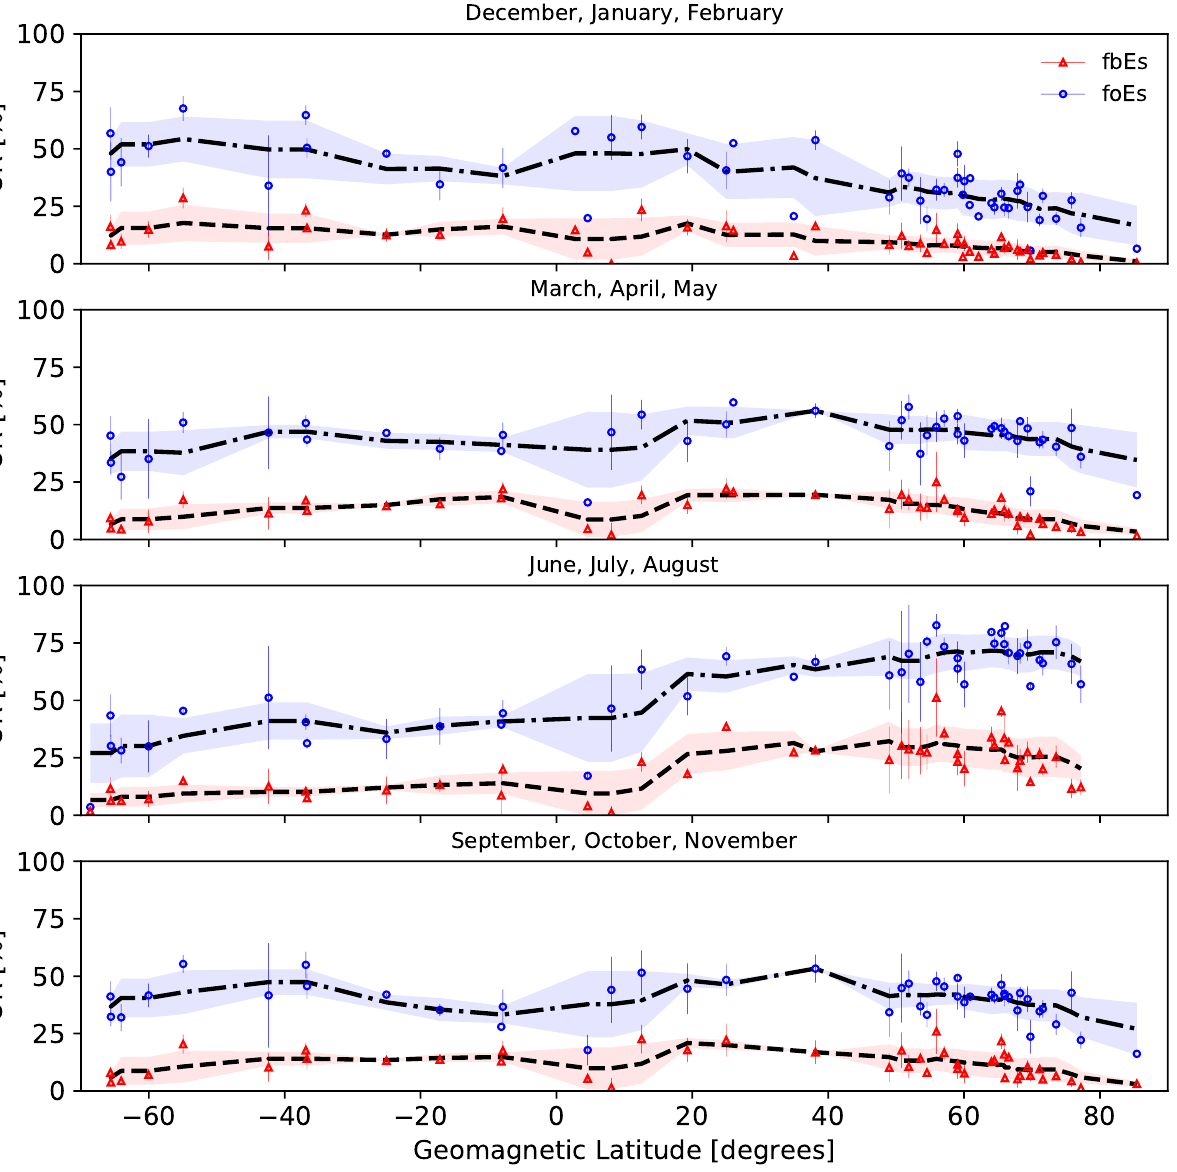
Figure 5. Occurrence rates for fbEs and foEs without a lower limit on intensity separated by geomagnetic latitude. Error bars correspond to the standard deviation of the yearly averages taken over all years with sufficient data. The trend lines and shading correspond to spatial running averages and standard deviations calculated with a ± 10 ◦ window,